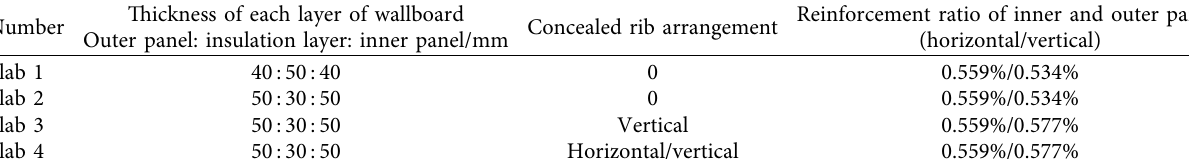
Table 3: Test board basic parameters.